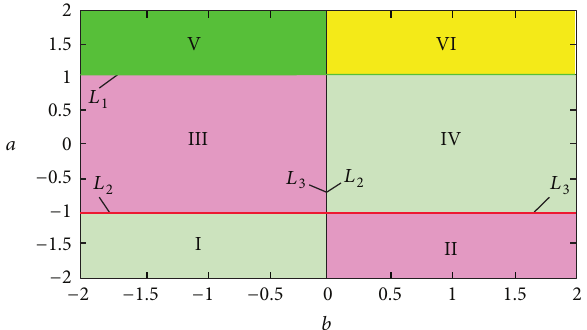
Figure 9: The stable region on the parameter plane (𝑎,𝑏)